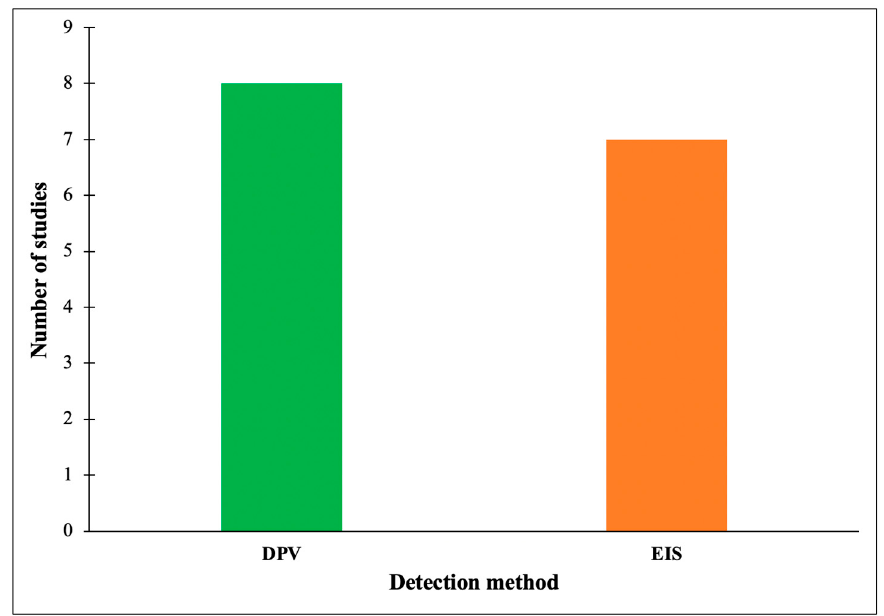
Figure 4. Detection method commonly applied for fabrication of electrochemical aptasensor.